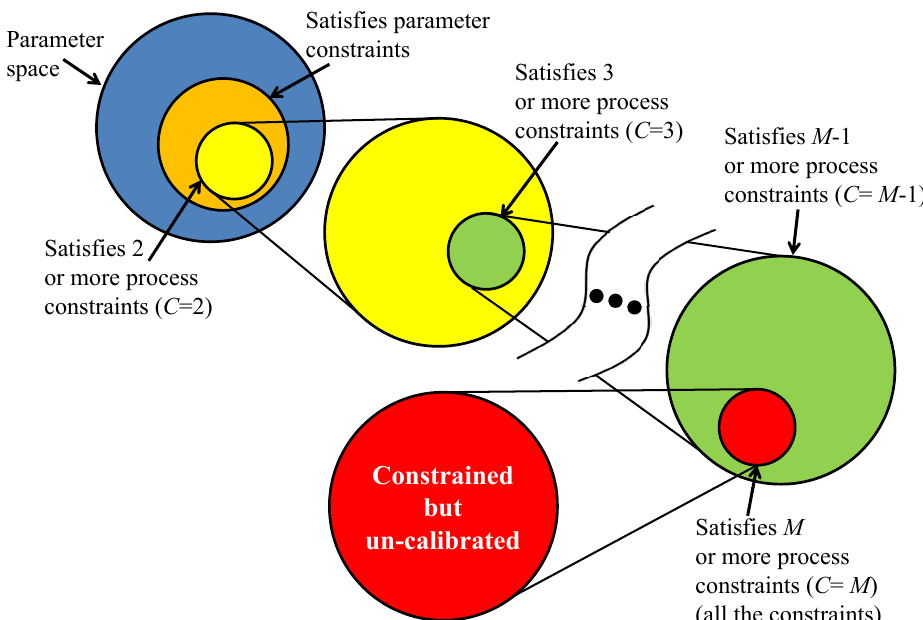
Figure 3. A conceptual illustration of stepwise search for the parameter space satisfying all of the parameter and process constraints.